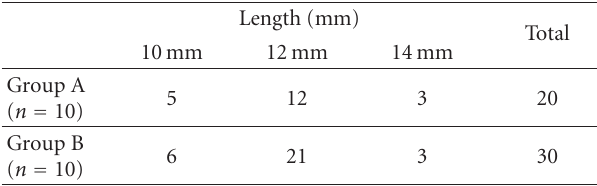
Table 1: Characteristics of the groups of the study. Table 2: Distribution of lengths of inserted